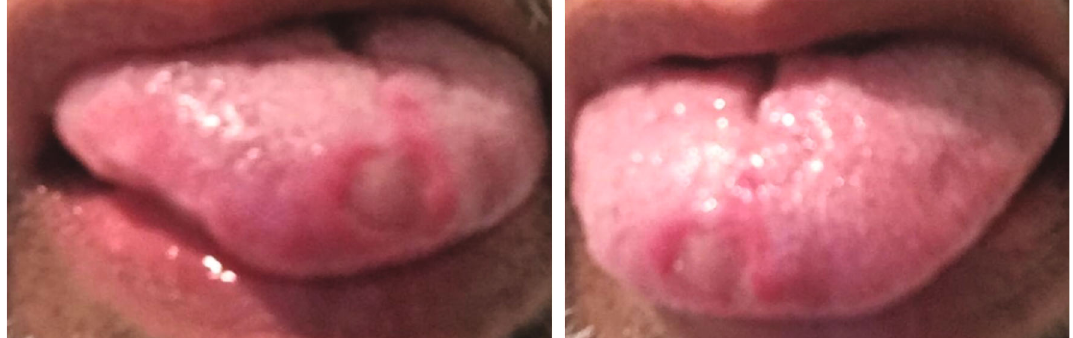
Figure 1: Ulcerative lesion with red halo on the dorsum surface of the right side of the tip of the tongue.